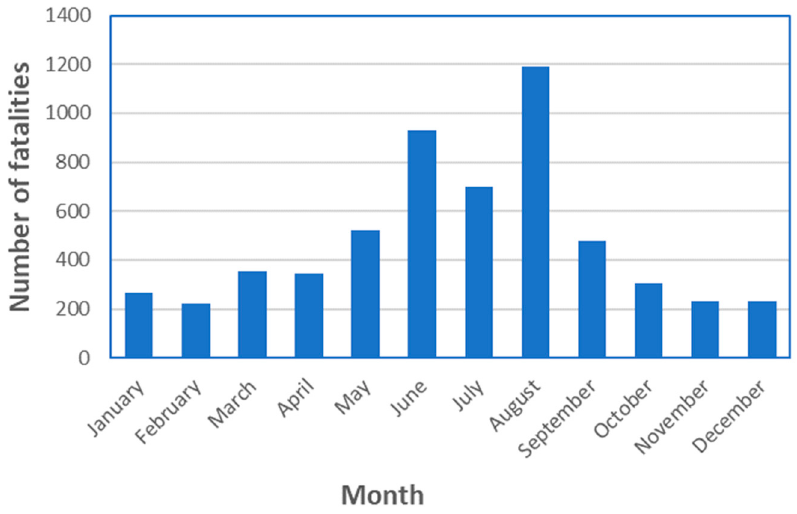
Figure 5. Monthly distribution of flood fatalities in the contiguous US (1959–2019) .